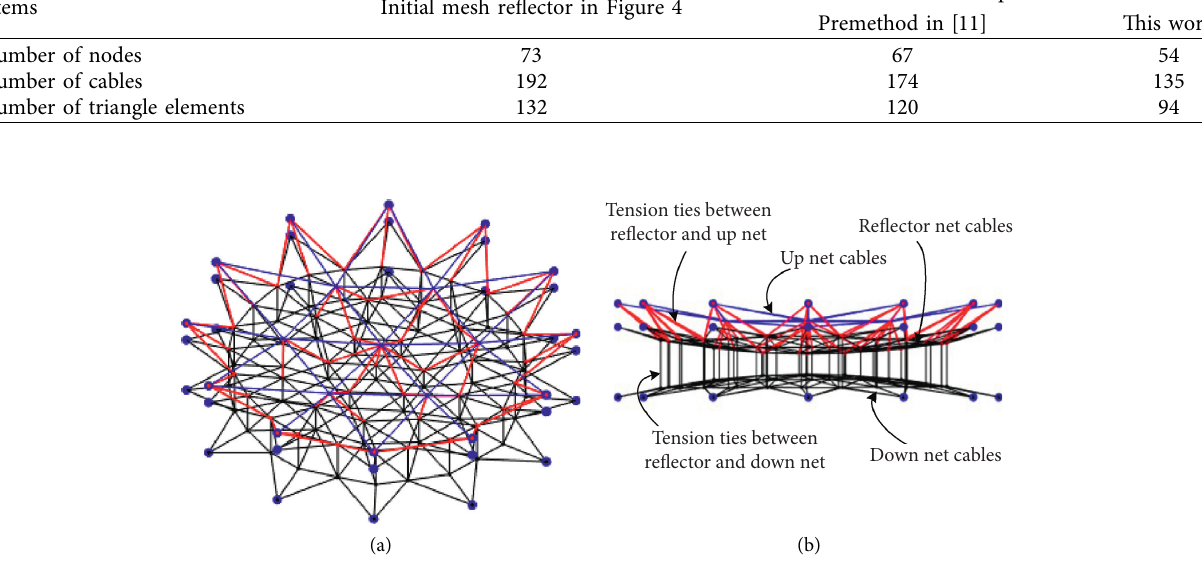
Figure 9: 3-layered cable net structure with the obtained mesh-shaped reflector. (a) Isometric view. (b) Side view. Table 4: Pretension distribution of the obtained 3-layered mesh antenna.